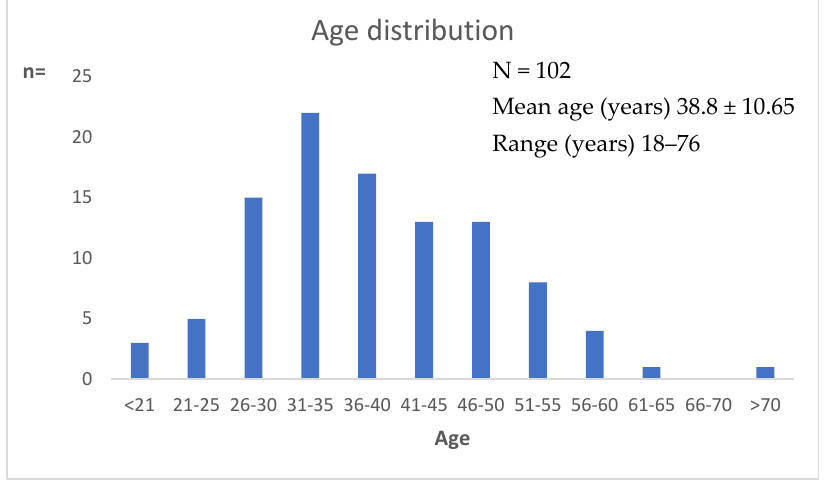
Figure 2. Age distribution of women with leptothrix.